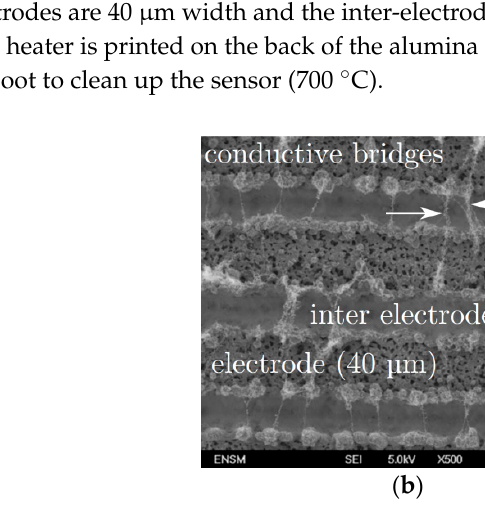
Figure 3. ( a ) Illustration of the resistive soot sensor; ( b ) Typical scanning electron microscopy of the